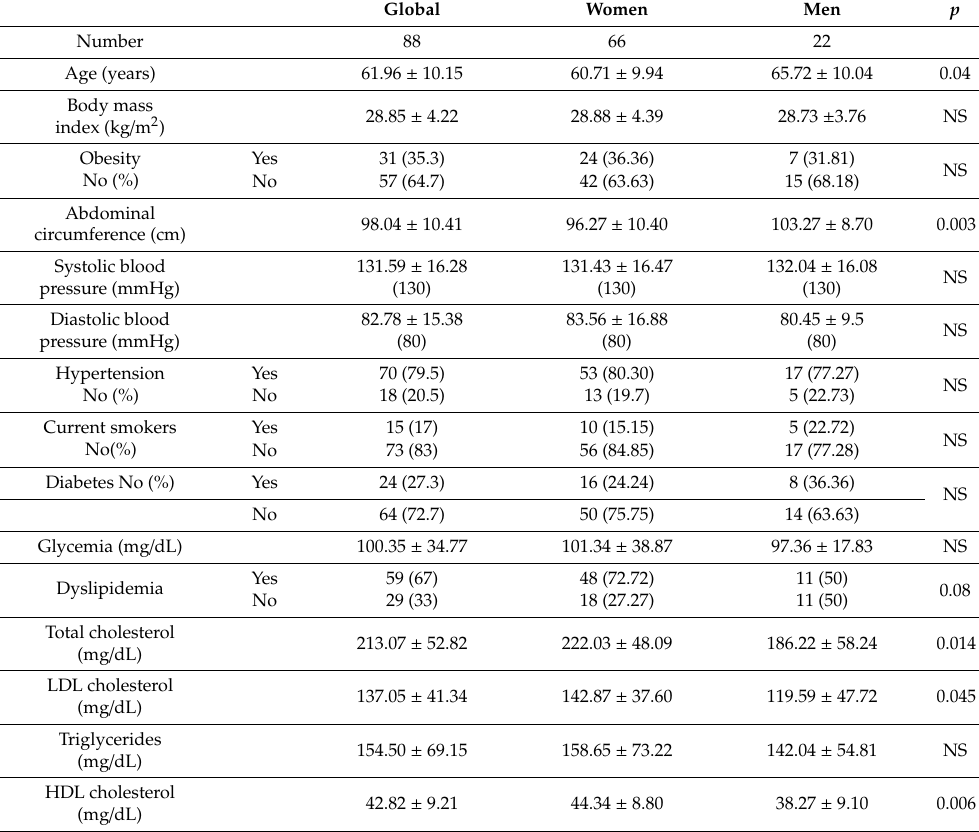
Table 1. Subjects’